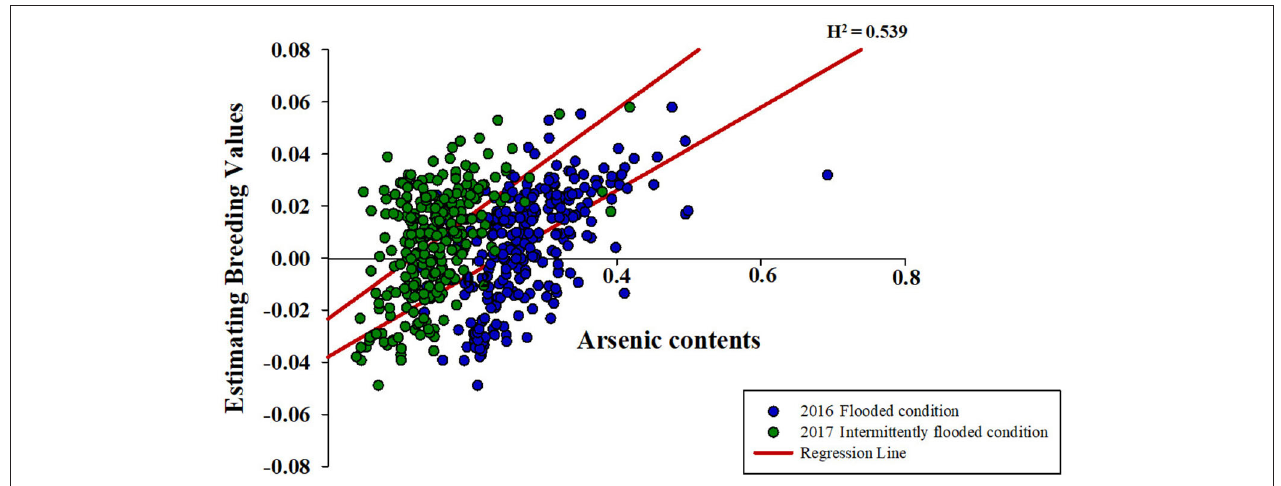
FIGURE 2 | Correlations between estimating breeding values (EBVs) and arsenic contents. Green circle indicates arsenic contents of the 273 rice accessions grown under the flooded condition in contaminated soil. Blue circle indicates arsenic contents of the 273 rice accessions grown under the intermittently flooded condition in contaminated